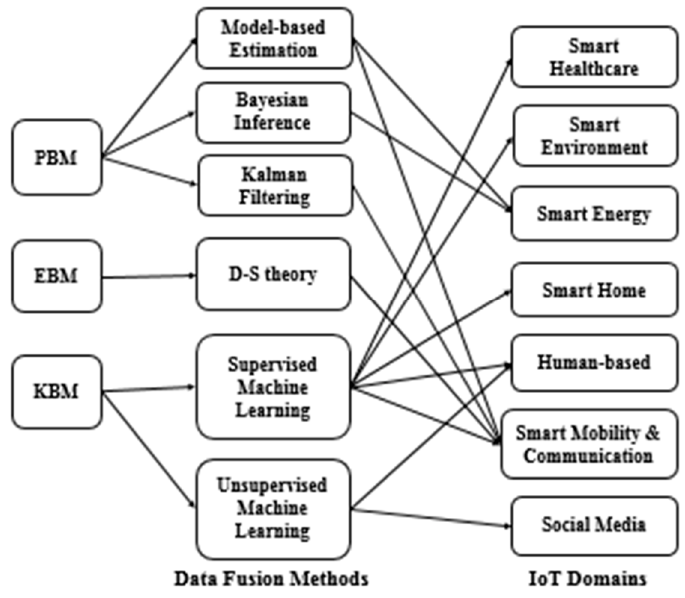
Figure 1. Data fusion methods considered for different IoT domains.